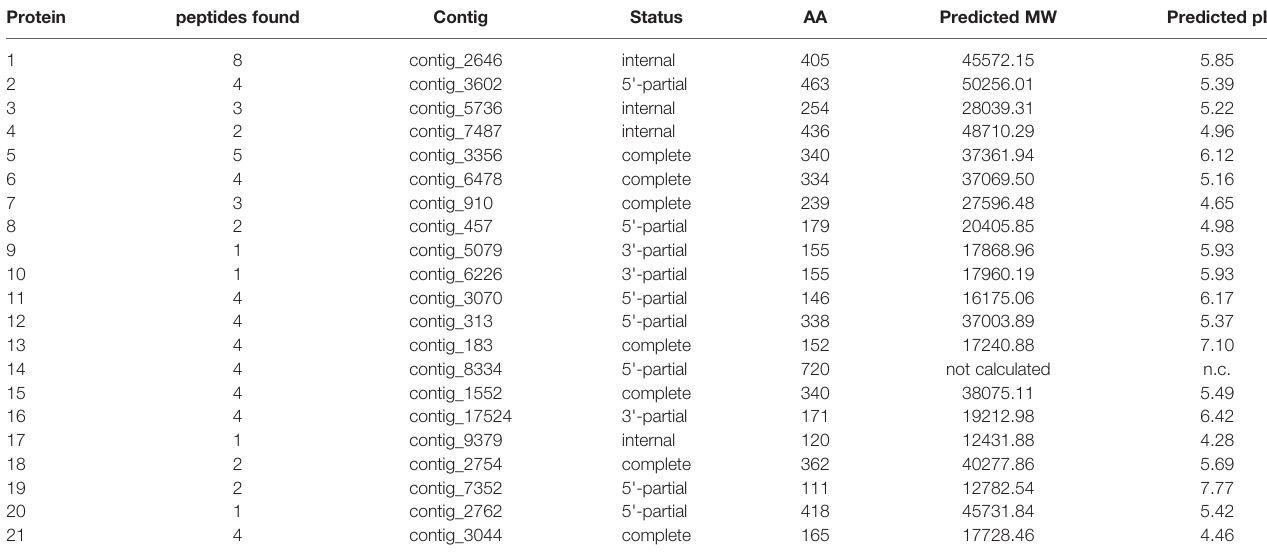
TABLE 1A | List of proteins extracted from siliceous spicules of P. fi ciformis . Protein peptides found